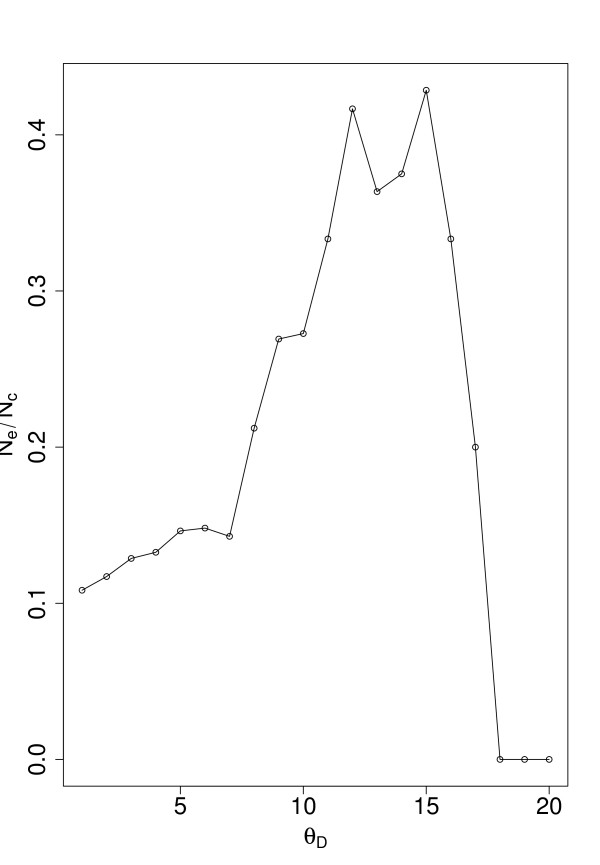
Ne/Nc in dependence on ΘD.